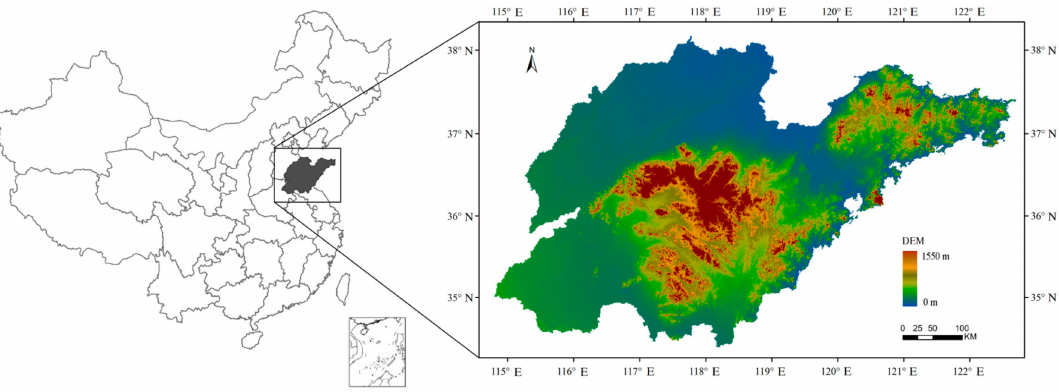
Figure 1. Study area location